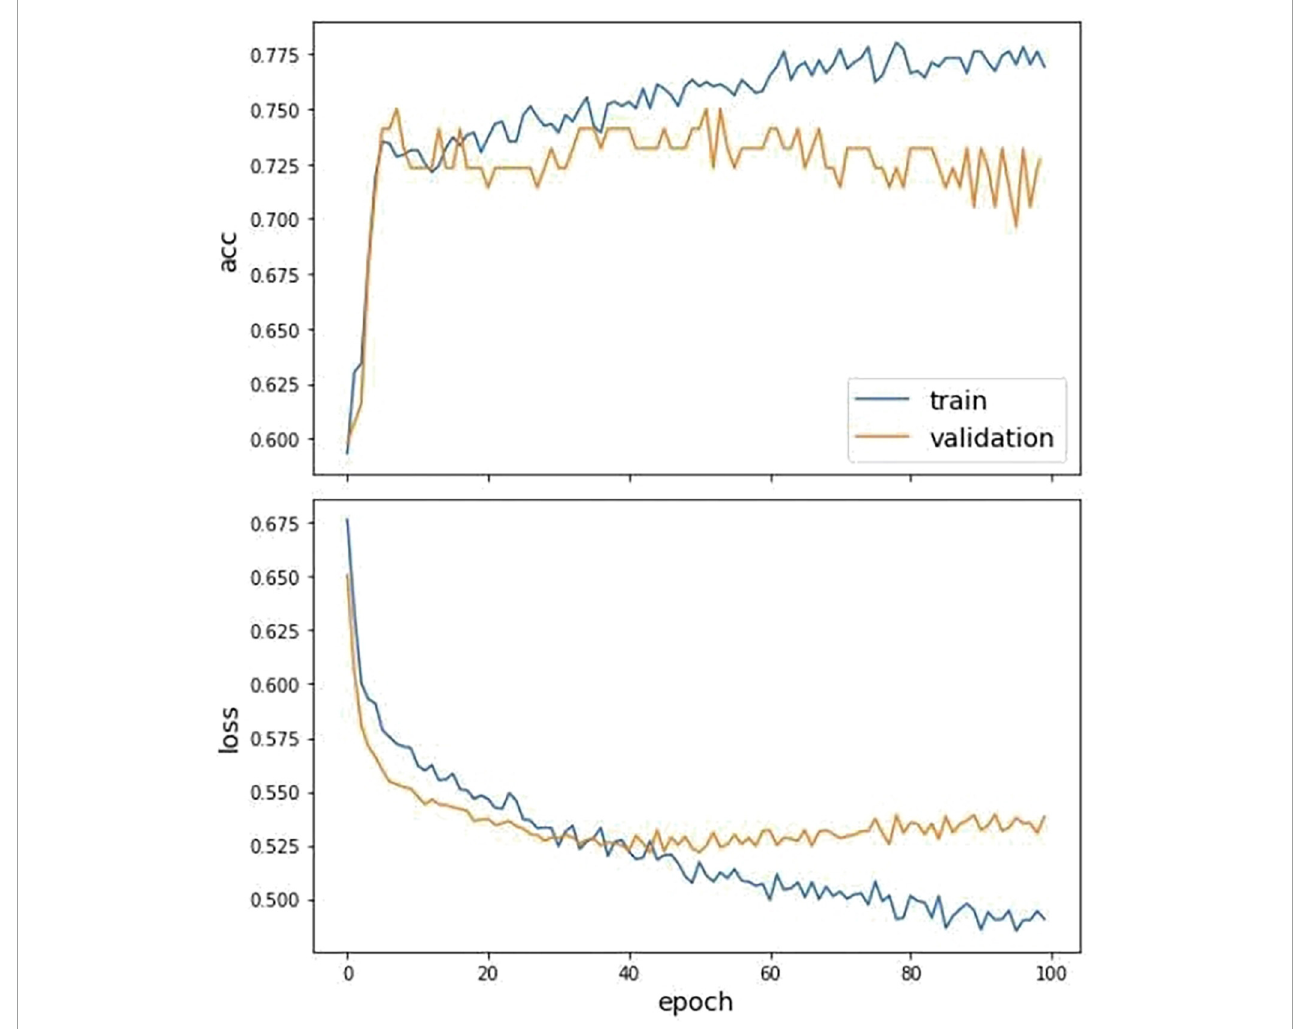
FIGURE4 The fitting curve of accuracy and loss of the training and test dataset. The above figure is the training history curve of accuracy, and below is the loss curve. Moreover, the orange is validation, and blue is the training